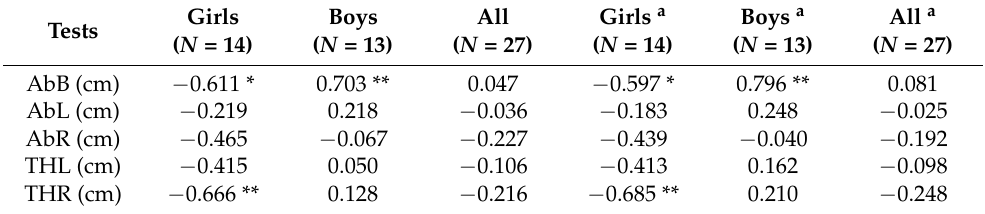
Table 3. Correlations between jumping and hopping and vitamin D, considering both the whole sam- ple, and male and female athletes separately, with and without the covariate body mass index